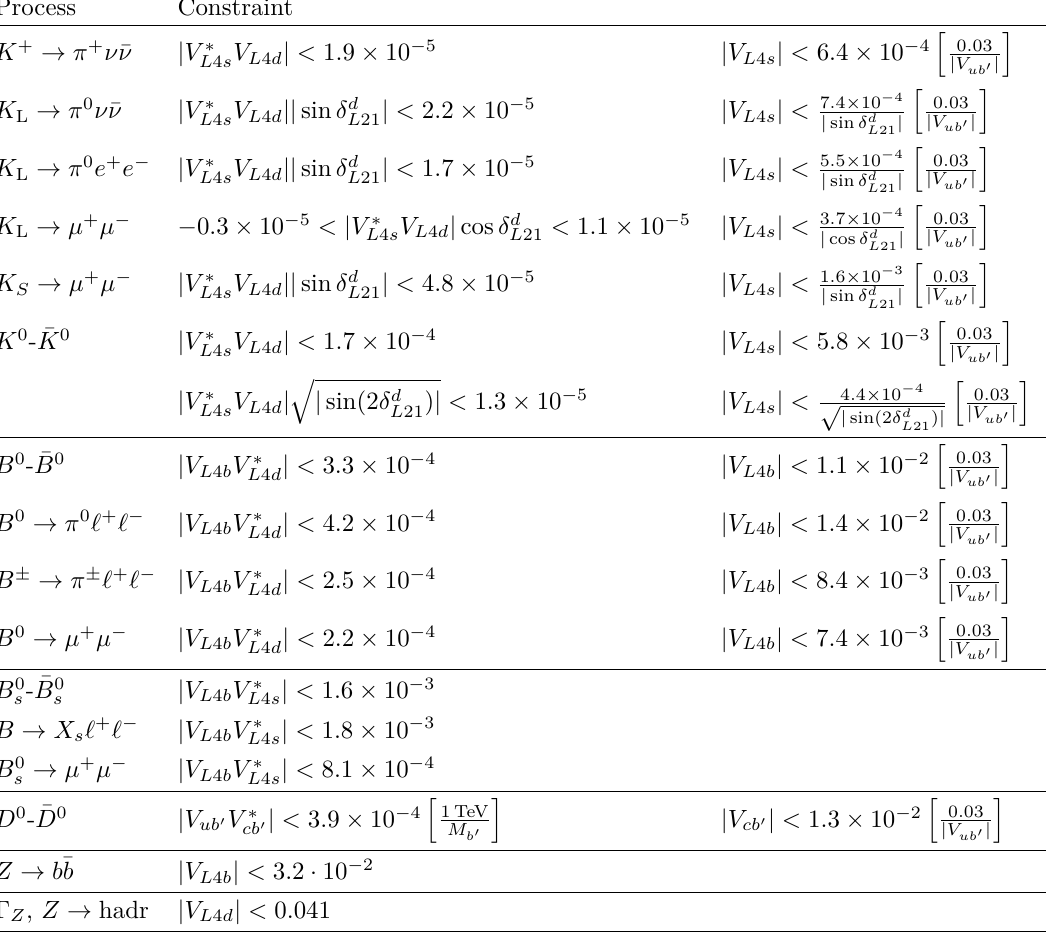
Table 6 . Limits on the mixing of the SM three families with a fourth down-type vector-like isosinglet. As in eq. (4.12), ( δ d